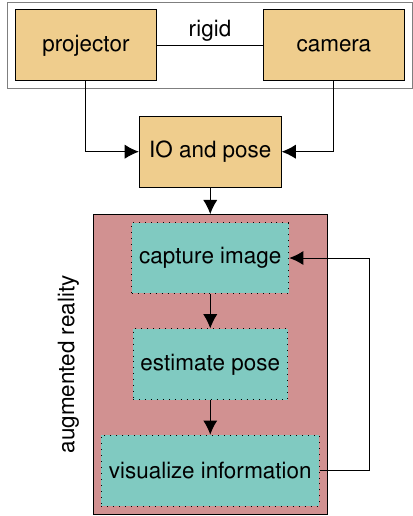
Figure 2. Flowchart of required steps to combine real and virtual world with a projector-based augmented reality